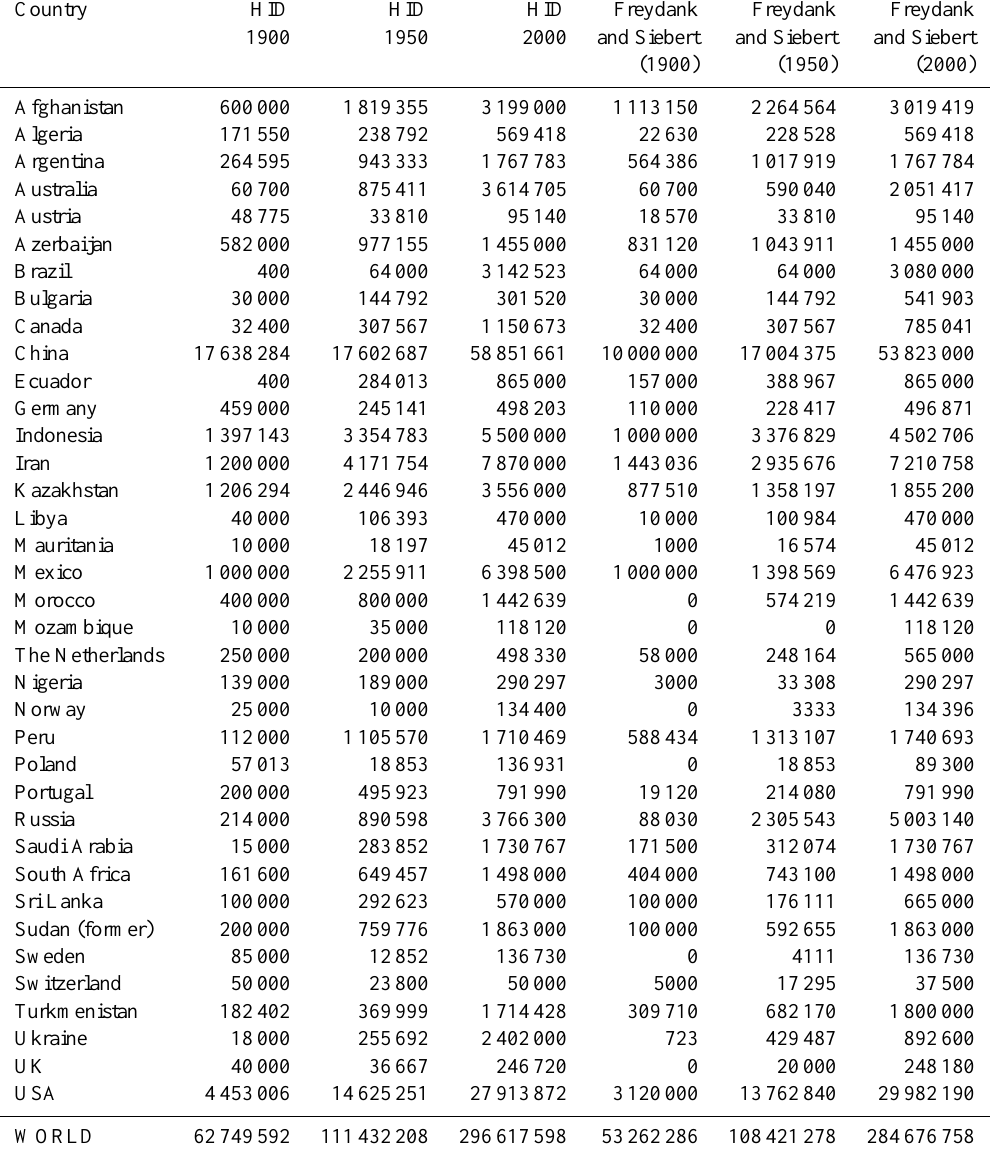
Table A2. Area equipped for irrigation (AEI_SU) in the historical irrigation data set (HID) and the historical irrigation inventory at the national scale (Freydank and Siebert, 2008) for years 1900, 1950, and 2000 (ha). Only countries with considerable differences between AEI in HID and Freydank and Siebert (2008) output are shown. Units are